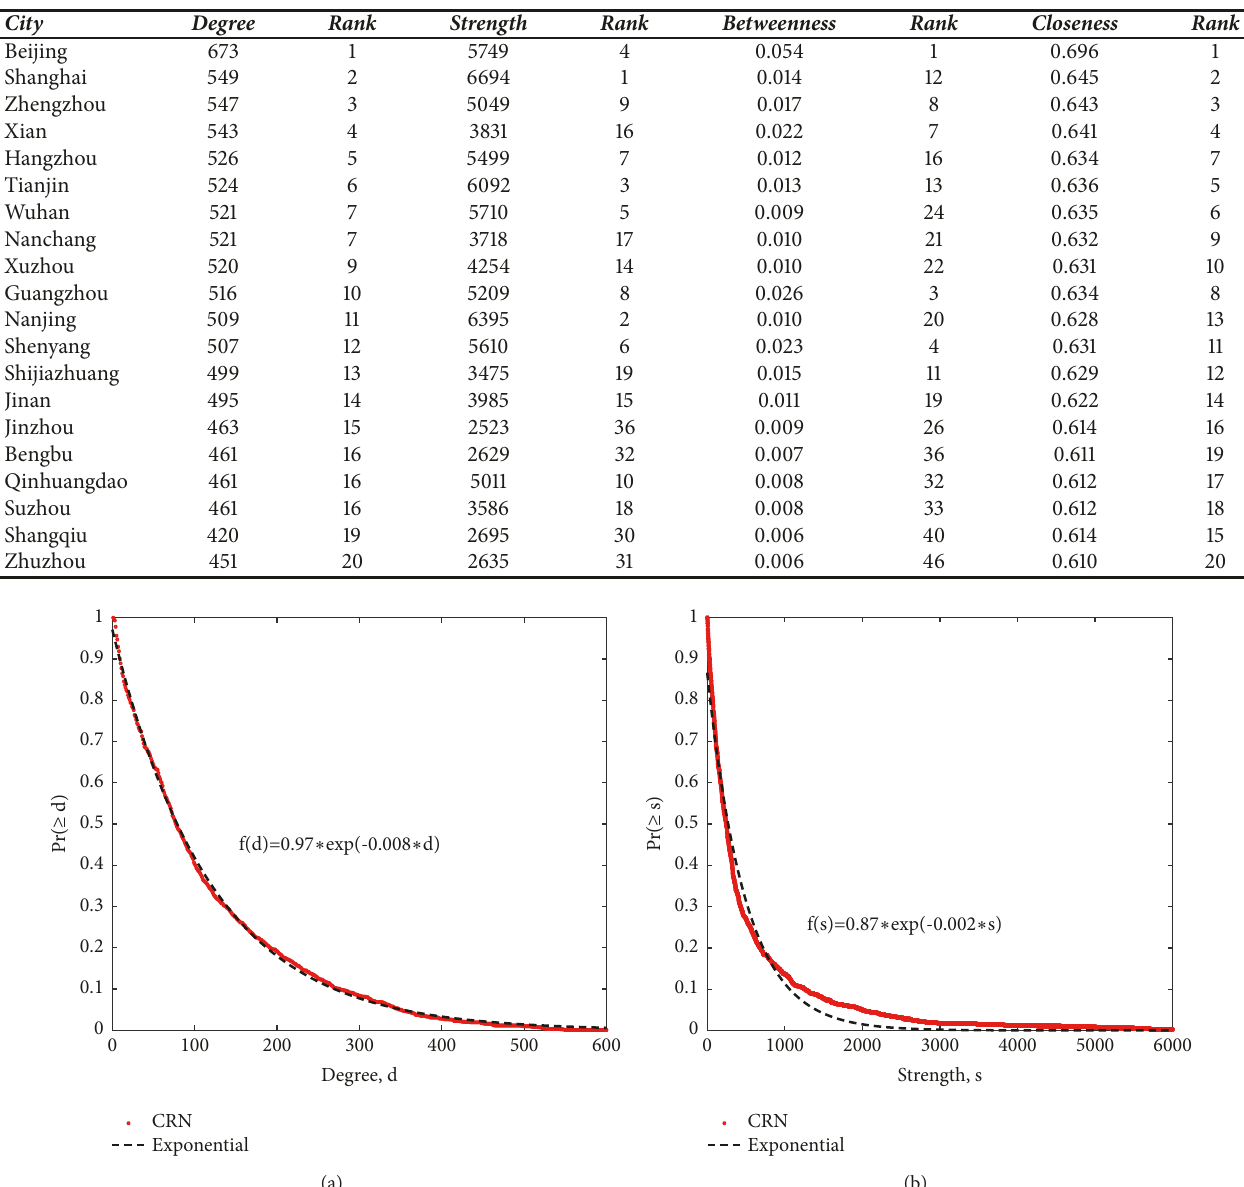
Table 2: The top 20 cities ranked by degree.